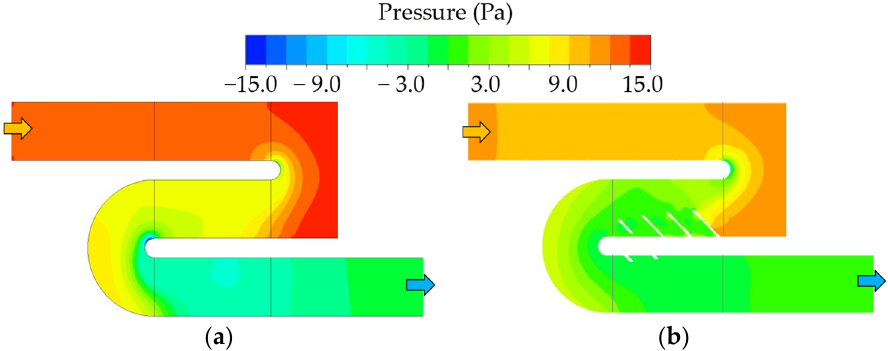
Figure 21. Pressure distributions in the middle section of the serpentine channel: ( a ) baseline model; ( b ) TO model with diamond-TPMS structure.